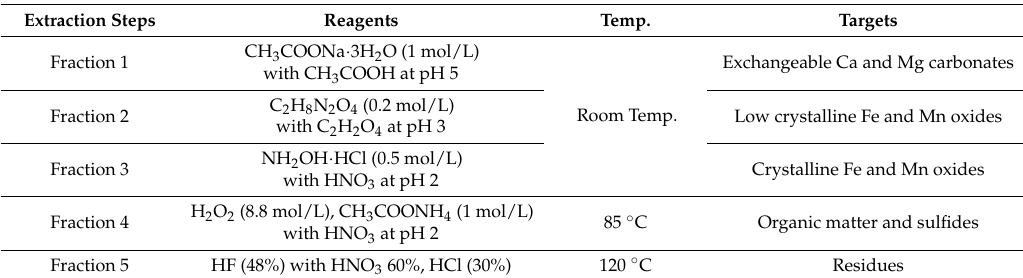
Table 1. Sequential extraction scheme in present